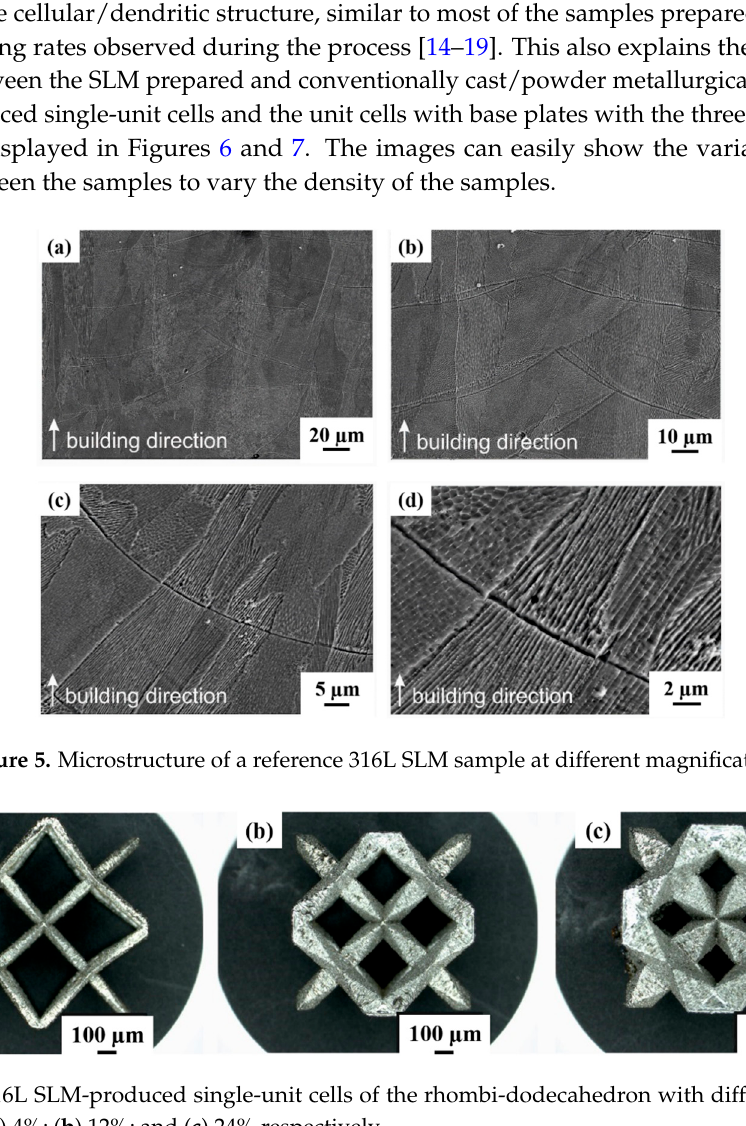
Figure 4. X-ray diffraction patterns of the gas-atomized 316L powder and the sample produced by selective laser melting.